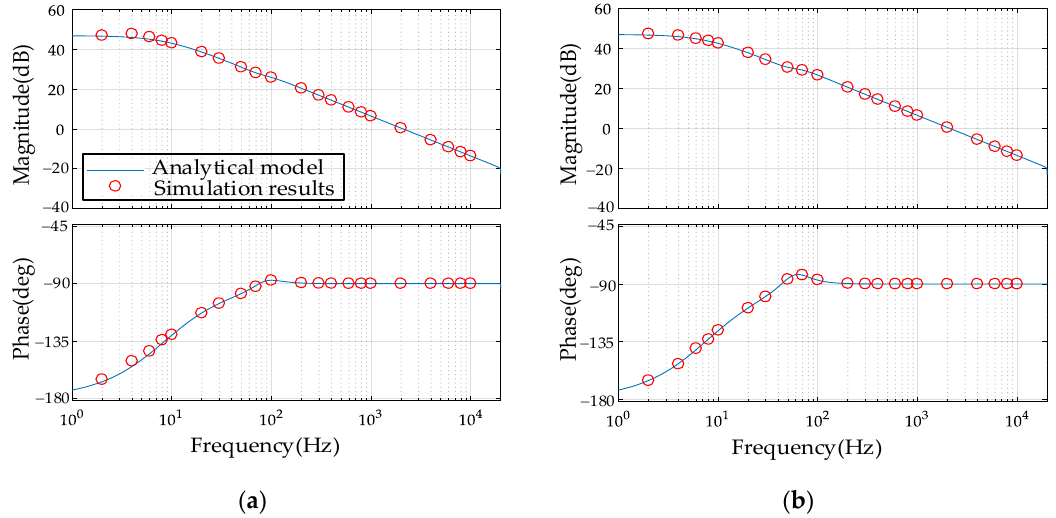
Figure 16. Bode diagram of the load impedance: ( a ) input impedance Z L ( s ) based on the IDCO method, ( b ) input impedance Z L _ IPR ( s ) based on the proposed IPR